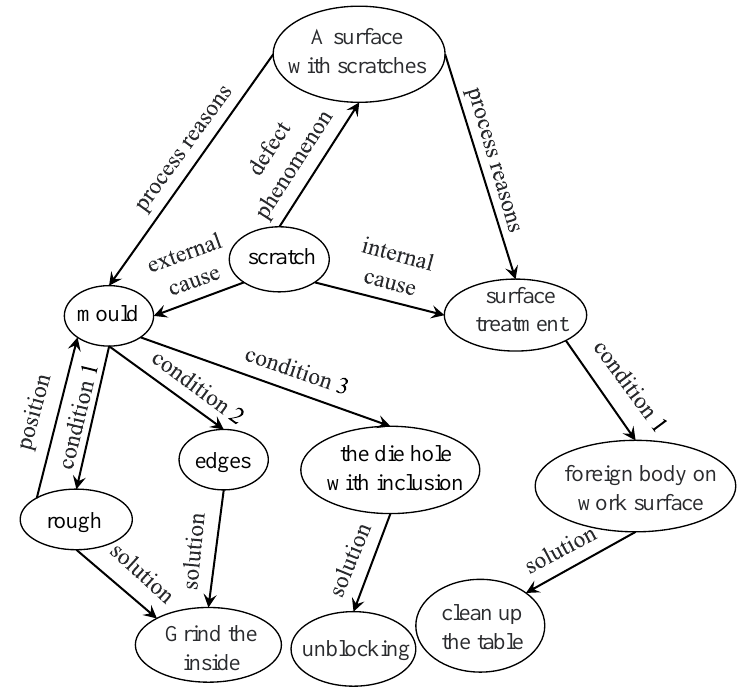
Figure 14. Network knowledge structure diagram of “ scratch “ defect.